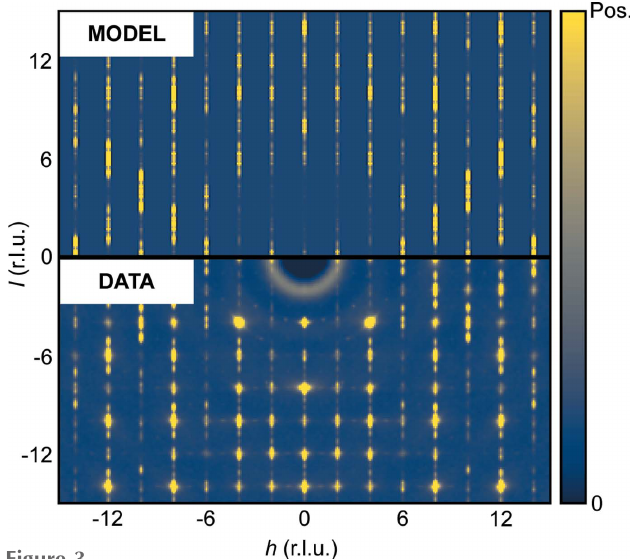
Figure 3 Experimental (bottom) and modelled (top) X-ray diffuse scattering from natural bixbyite single crystal in the h 0 l plane of reciprocal space. The experimental data have been convoluted with a Gaussian function with (cid:2) = 0.5 pixels to ease comparison with our model data, which are broadened due to the size of the supercell model. A constant background term has been added to the model